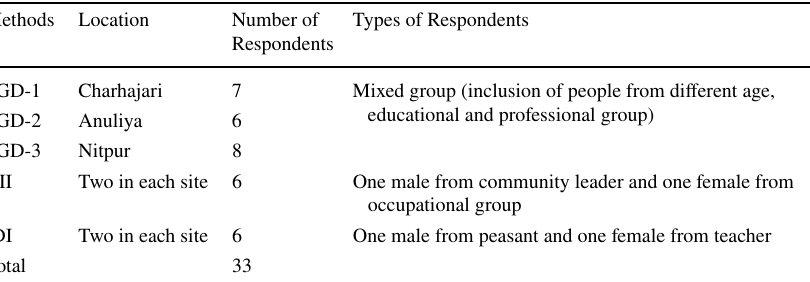
Table 1 Methods and respondents Methods Location Number of